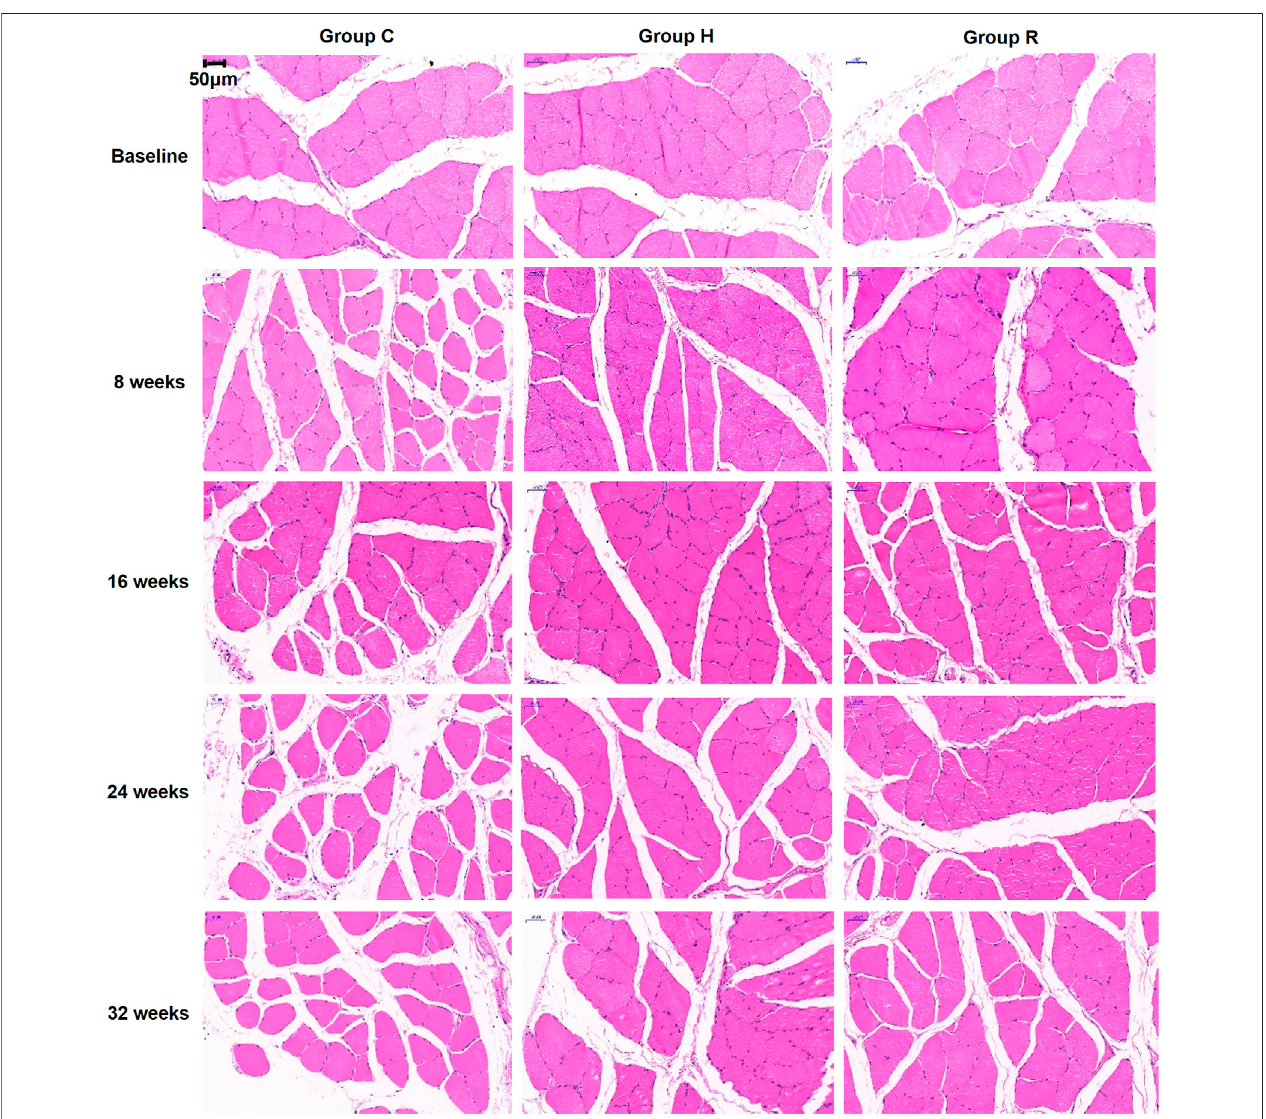
FIGURE 1 | HE staining sections of soleus muscle of rats in each group were observed under 400 times microscope.